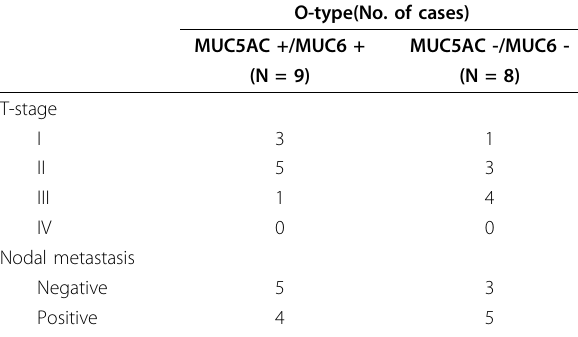
Table 8 Correlation of Tumor Parameters and MUC5AC and MUC6 Coexpression with